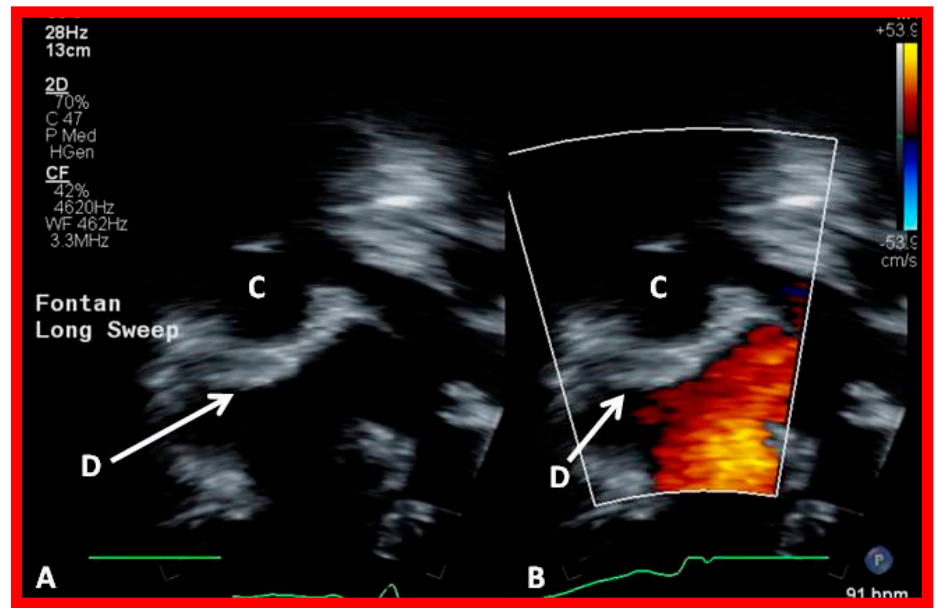
Figure 10. Echo–Doppler recordings in an apical four-chamber view illustrating the location of the Amplatzer Occluder device (D) (arrows in ( A , B )). No residual shunt is demonstrated ( B ). Conduit (C) is labeled. Reproduced from [21].